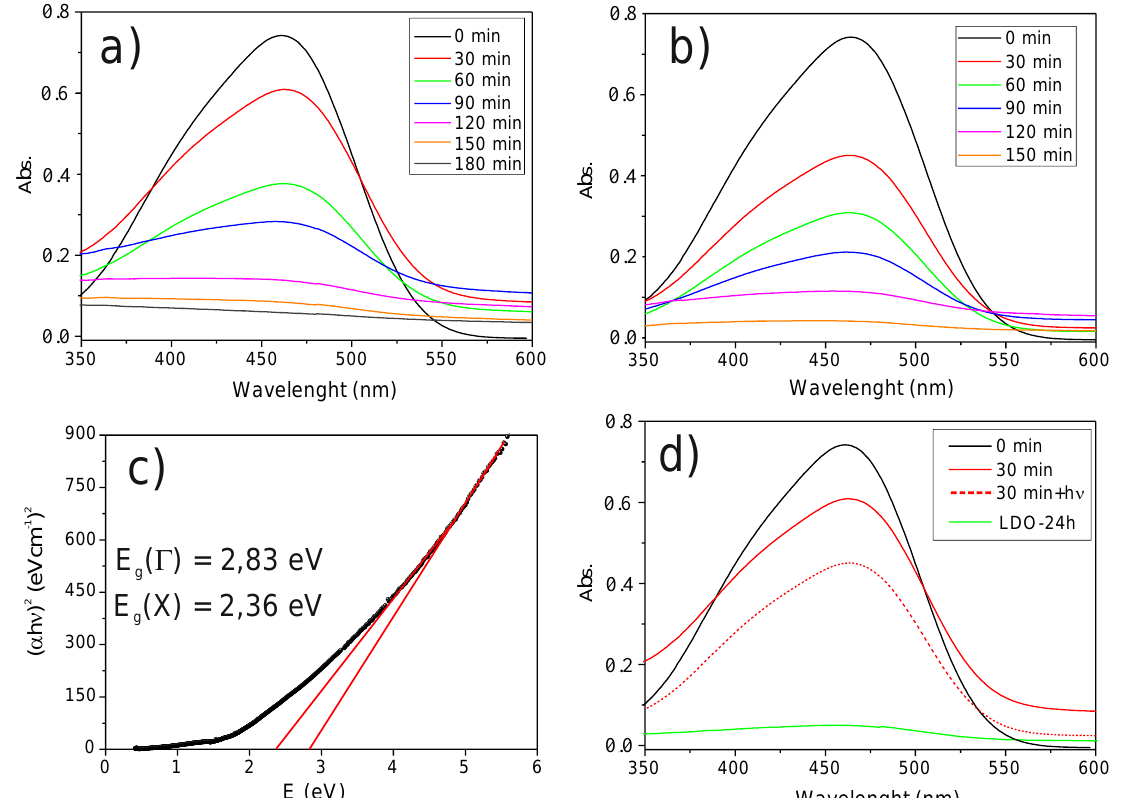
Figure 5. ( a ) MO in the solution after oxidation by calcined NiFe 2 O 4 -LDH composite with visible irradiation and ( b ) with UV-405 nm irradiation. ( c ) Tauc plot of NiFe 2 O 4 NPs showing the two direct optical band gaps. ( d ) Comparison of MO in the solution after 30 min of oxidation by calcined NiFe 2 O 4 -LDH composite under visible and 405 nm light. Green plot shows the MO in solution after 24 h adsorption by calcined LDH. Table 1. Removal percentage of MO at different time reactions using calcined NiFe 2 O 4 -LDH composite under visible light and UV light of 405 nm. % Removal % Removal Time (min) (Visible Light)